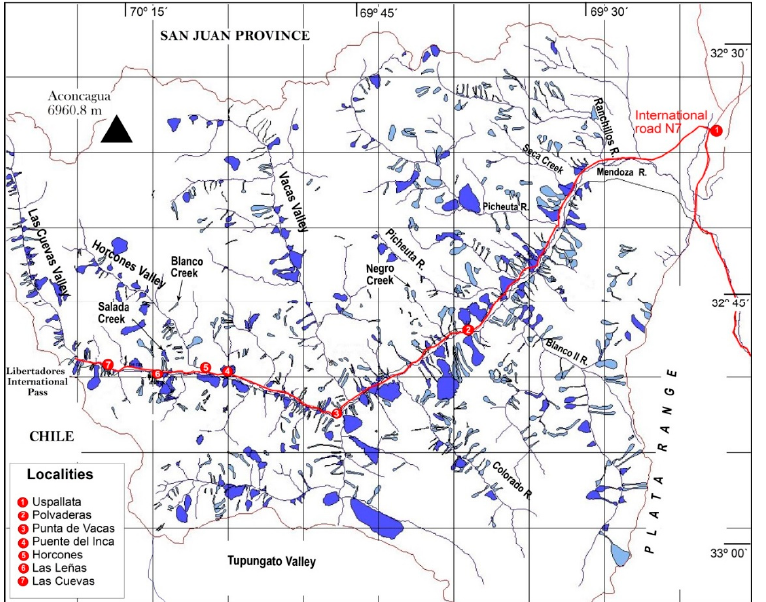
Figure 5. Inventory of debris flows (DFs) identified by remote sensing along the Mendoza Valley (32°30 ′ S) (after [96]). Light blue polygons represent an isolated DF and dark blue ones correspond to debris flows area where small DFs has been gathered. A limited spatial distribution of DFs is clearly observed in the highest mountain zones due to glacial domain. Along the main valley, several DF geoforms match with historical records (see Figure 3).